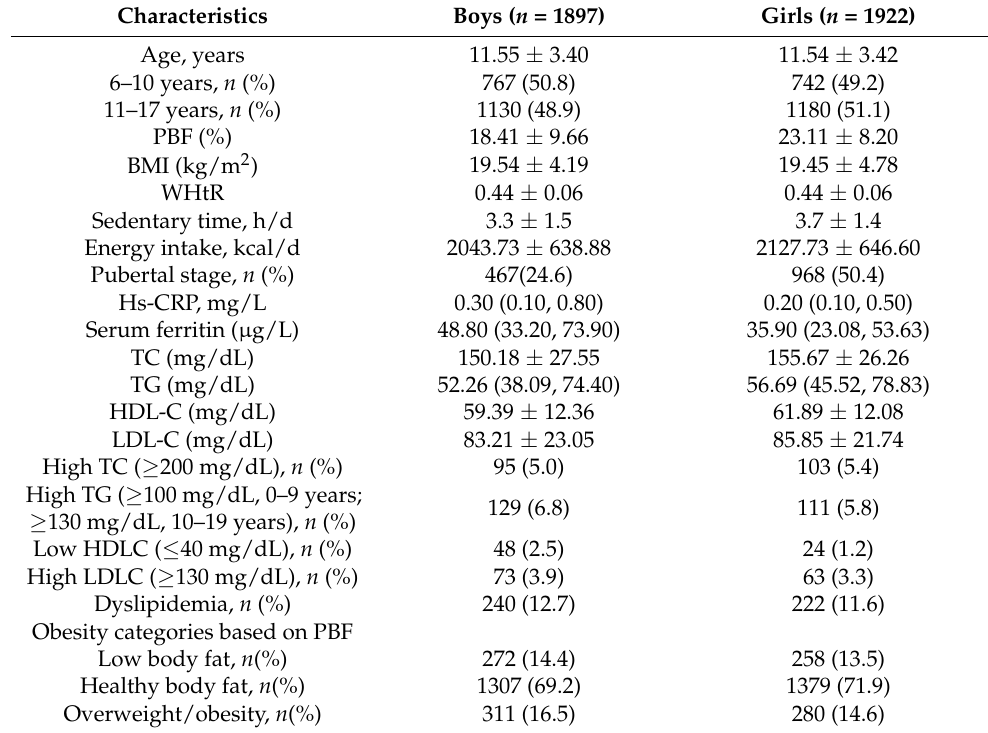
Table 1. Characteristics of the study